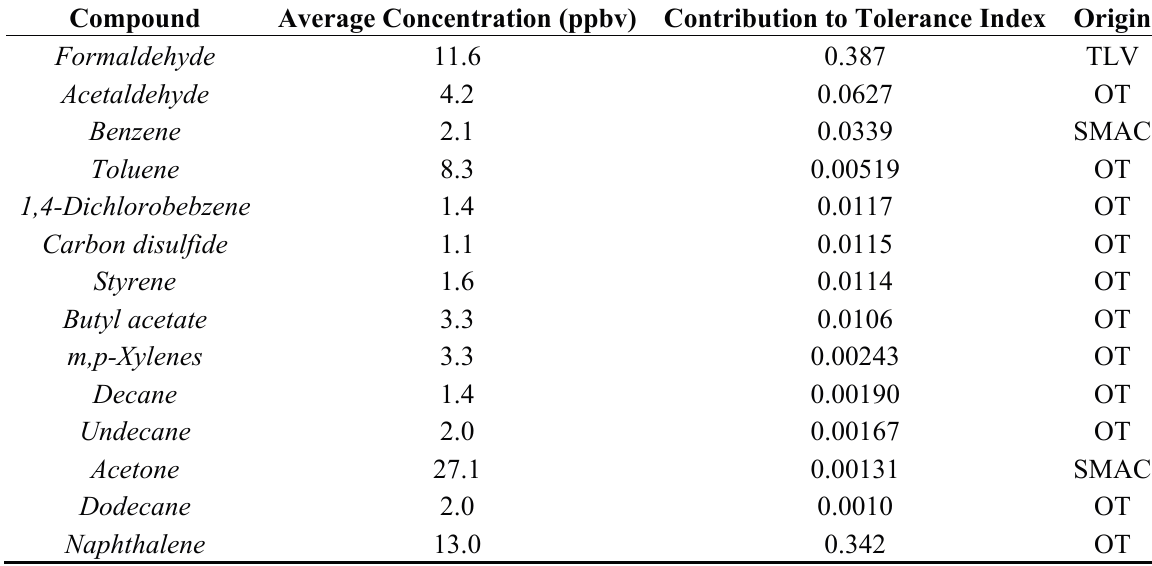
Table 1. Selected VOCs found in the US EPA BASE study and their contribution to UTRC’s proposed tolerance